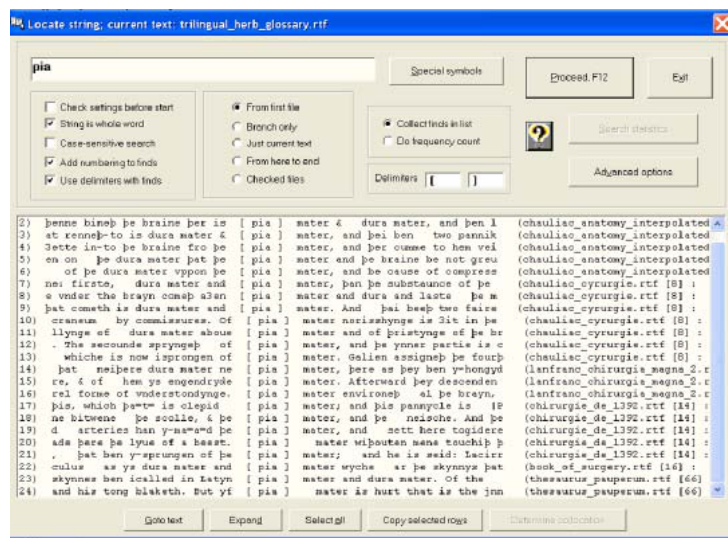
Table 1: Occurrences of PIA MATER in MEMT